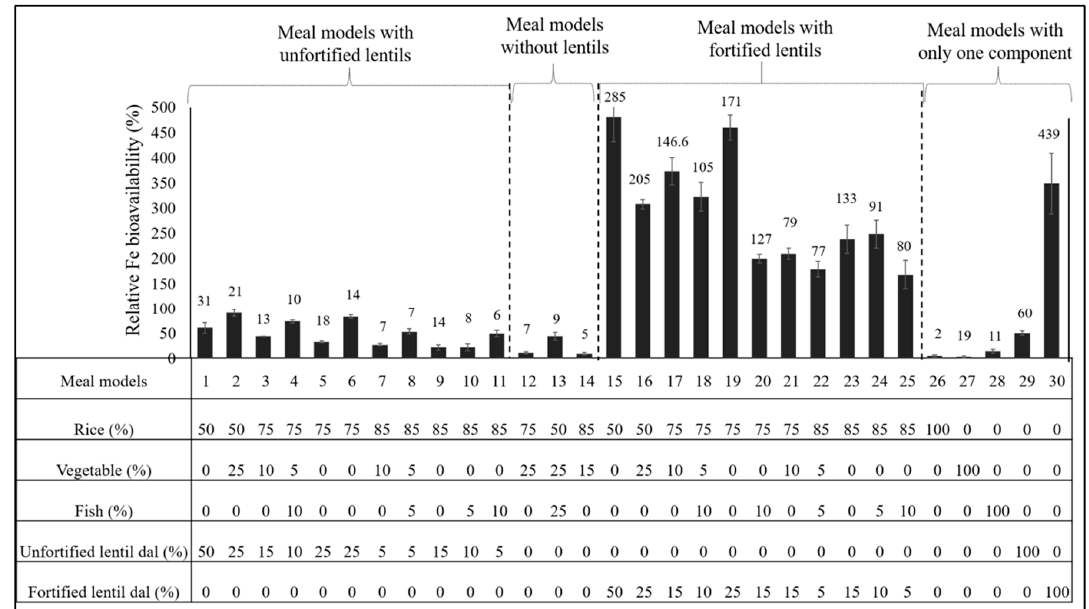
Figure 1. Relative iron bioavailability (RFeB%) and Fe concentration (µg g − 1 , above each bar) of 30